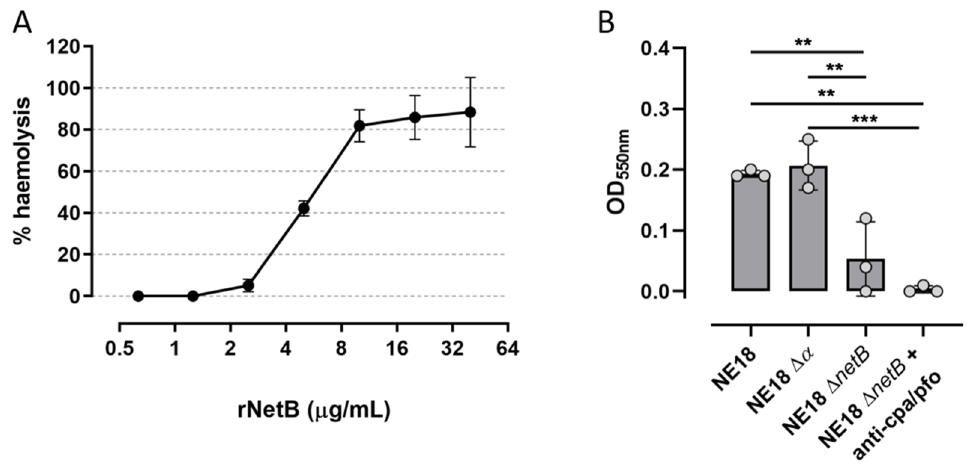
Figure 4. ( A ) Chicken RBC haemolysis induced by a two-fold dilution series of rNetB (starting from 40 µg/mL). The % haemolysis was calculated relative to the negative control (chicken RBCs in HBSS, 0% haemolysis) and positive control (chicken RBCs diluted in dH 2 O, 100% haemolysis) and plotted on a log2 scale against chicken RBCs. ( B ) Comparison of haemolysis induced by the wild-type strain NE18, its alpha toxin mutant (NE18 ∆ α ), the NetB mutant (NE18 ∆ netB ) or NE18 ∆ netB pre-incubated with anti-alpha toxin and perfringolysin antiserum (anti-cpa/pfo). Haemolysis is observed by an increase in OD due to the release of haemoglobin from the RBCs. ** p < 0.01; *** p < 0.001